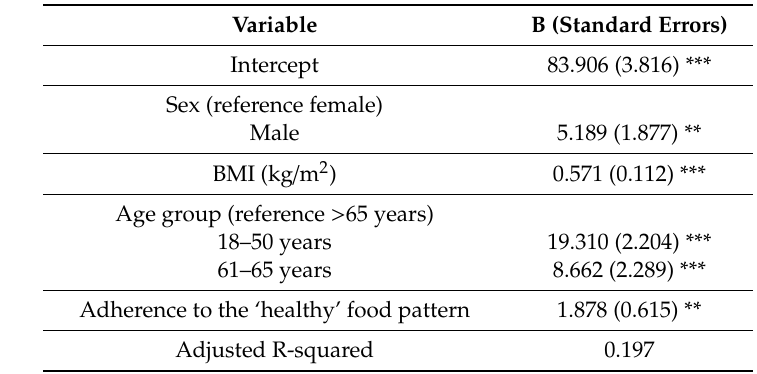
Table 5. Determinants of BUA (broadband ultrasound attenuation).